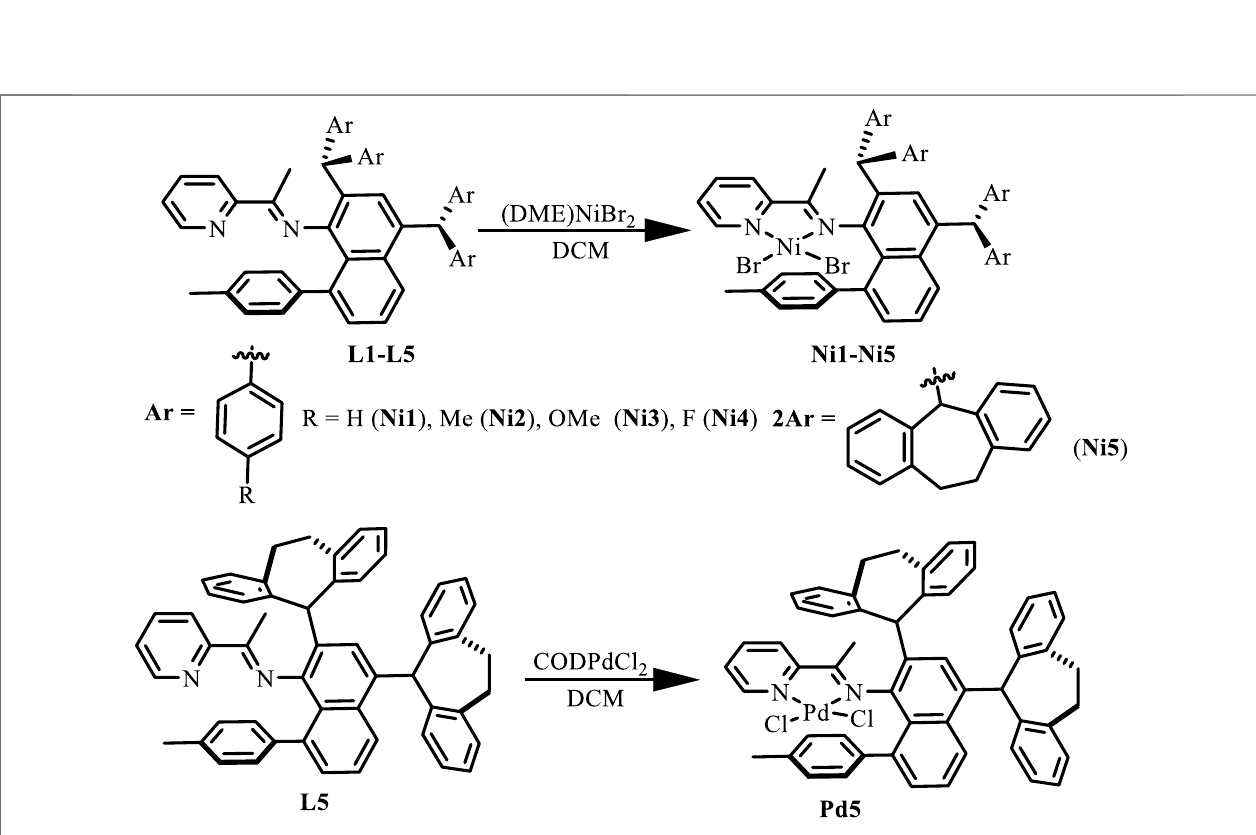
SCHEME 1 | Synthesis of “ semi-sandwich ” and “ sandwich ” type pyridine-imine Ni(II) ( Ni1 - Ni5 ) and Pd(II) ( Pd5 ) complexes.